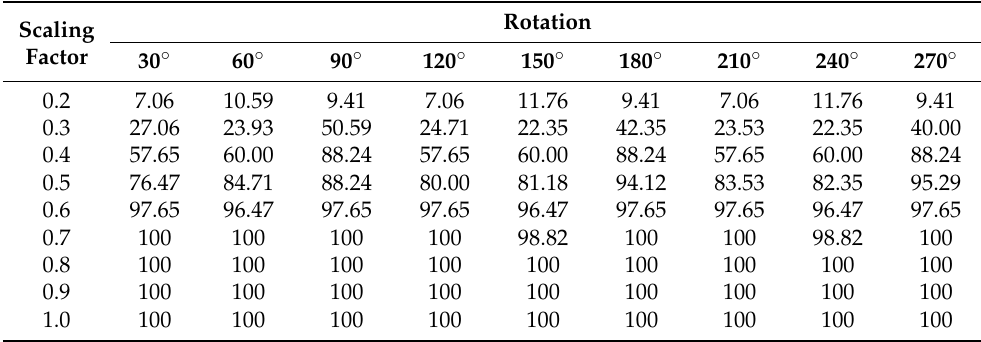
Table 1. The correct recognition rates for a combination of rotation angles and scaling factors for the proposed method for the printed Chinese character dataset.